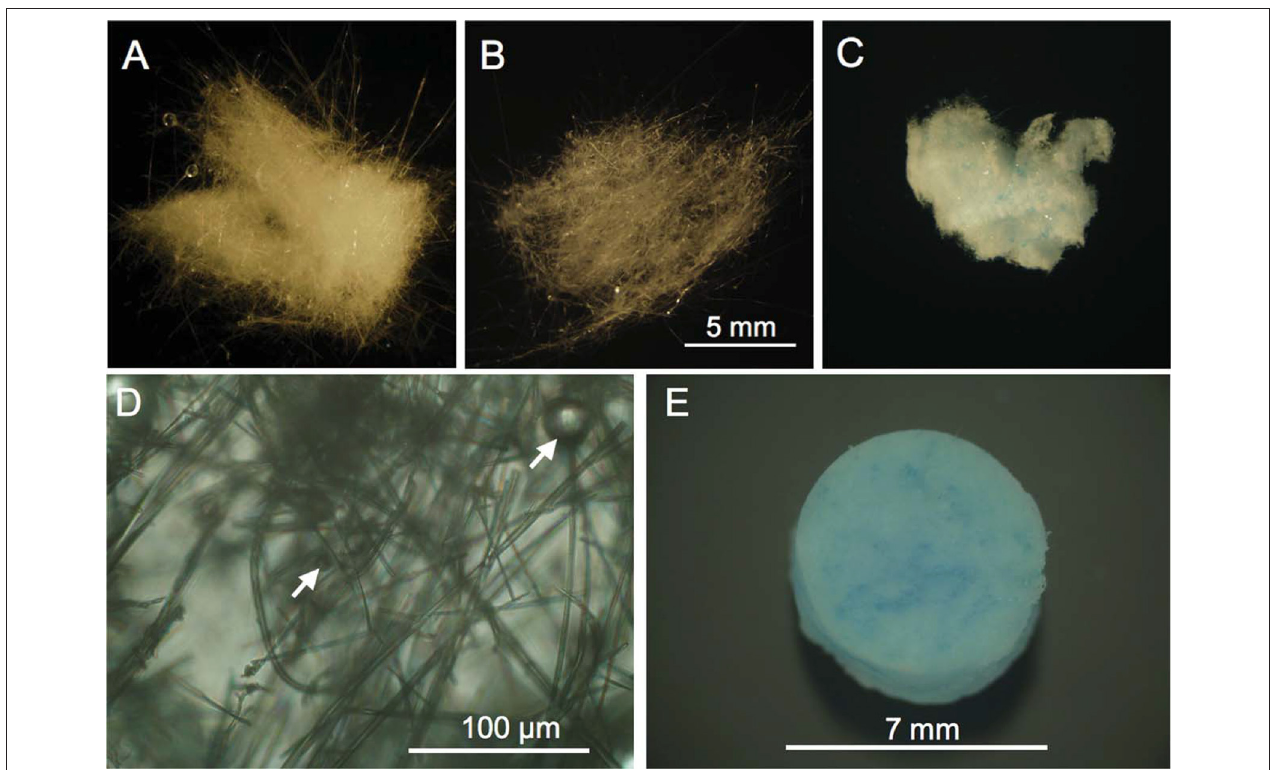
FIGURE 5 | Cotton-like fibrous scaffolds produced and implanted subcutaneously in rats including (A) 45S5 glass, (B) 13–93B3 glass, and (C) Cu-doped 13–93B3 glass; (D) higher magnification of the 13–93B3 glass microfibers with glass beads of variable size; (E) the mat of copper-containing 13–93B3 glass microfibers for implantation in rats (E) . Images reproduced from Lin et al. (2014) with